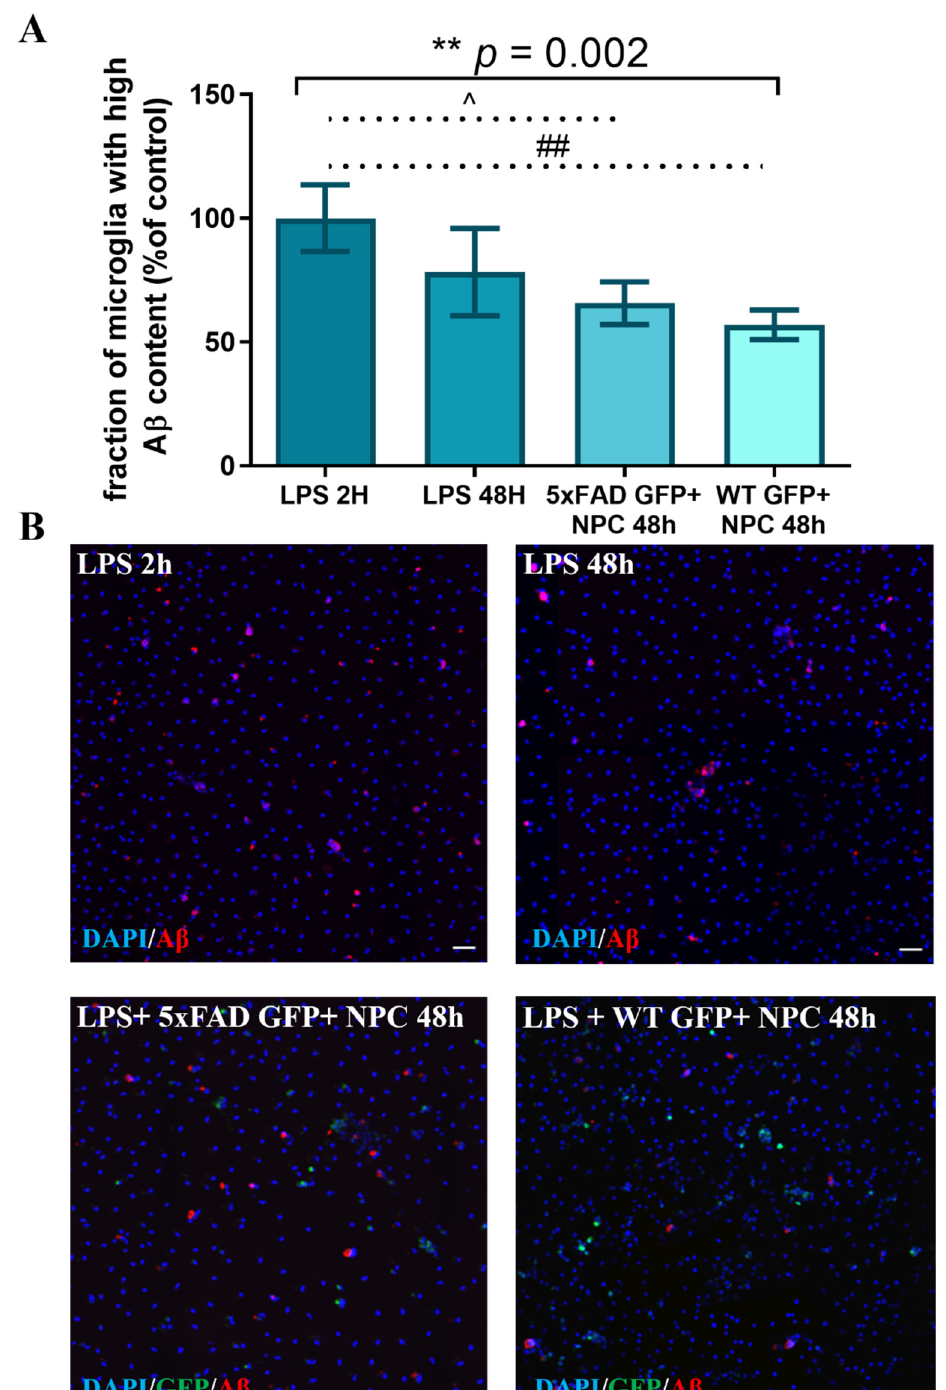
Figure 8. GFP+ NPCs from adult SVZ promote A β removal in microglia with high A β content after 48 h. ( A ) Co-culturing A β -loaded 5xFAD microglia with GFP+ NPCs induced a reduction of the fraction of microglia with high A β content after 48 h as compared to control. Quantification of microglia with high A β content was compared to control rate (LPS 2 h), which served as 100%. One-way ANOVA ** p = 0.002, post hoc analysis indicated that both WT and 5xFAD GFP+ NPCs promote A β removal. 5xFAD GFP + NPCs 48 h vs. LPS 2 h: ^ p = 0.012, WT GFP+ NPCs 48h vs. LPS 2h: ## p = 0.0025. ( B ) Representative images of microglia with high A β content at the 2 h baseline, and after 48 h in control and NPC-treated cultures. Blue = DAPI, green = GFP, red = A β , scale = 50 μ M.